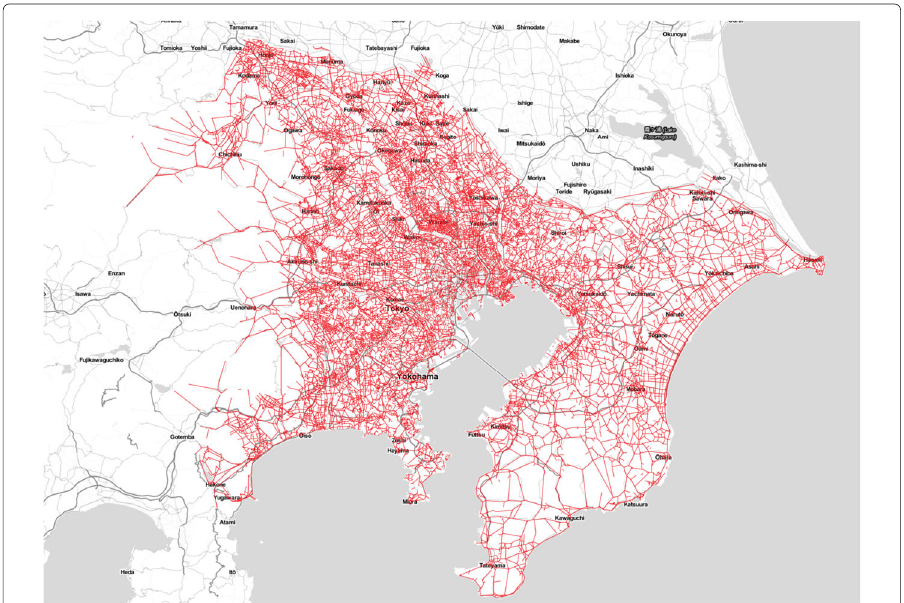
Fig. 6 A map of the Tokyo area showing the edges of the road network. Note that several large highways and roads labeled as smaller than tertiary have been excluded from this analysis. Map tiles by Stamen Design (2019), map data by OpenStreetMap(OpenStreetMap Contributors